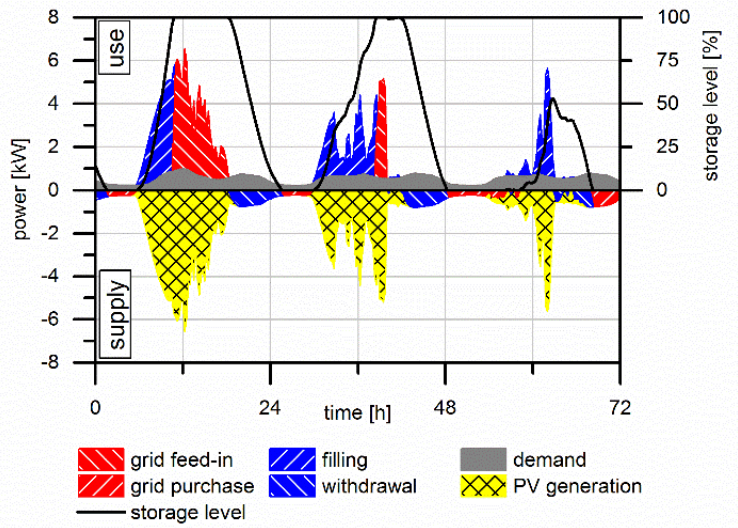
Figure 5. Storage behavior of a PV storage system on three days in April 2011 (PV 8.6 kW p , storage 8 kWh, demand 4752